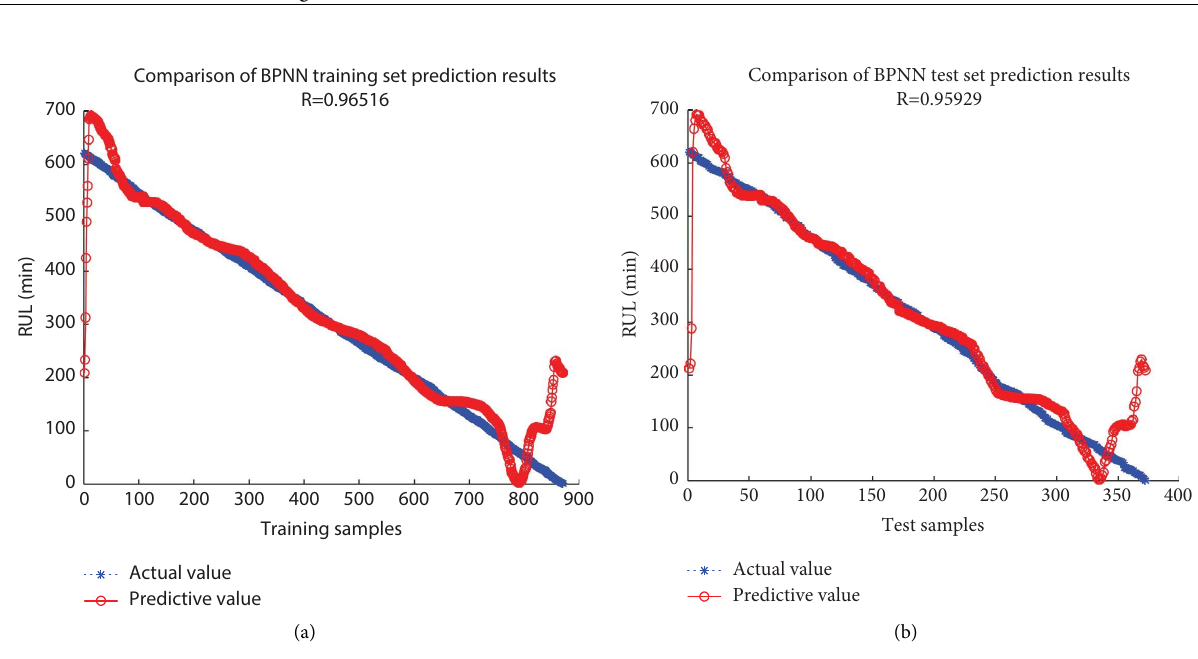
Figure 9: Prediction results of BPNN. (a) Training set. (b) Test set.